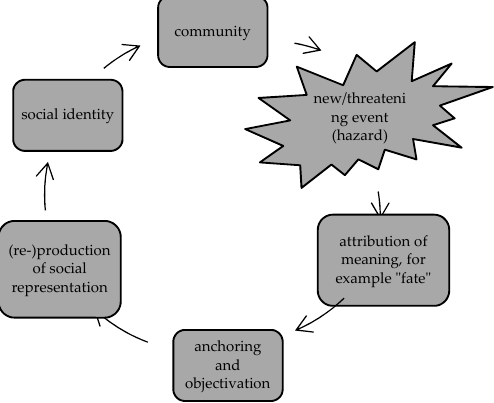
Figure 1. Emergence of social representation (own illustriation according to Figure 1 . Emergence of social representation (own illustriation according to [46])